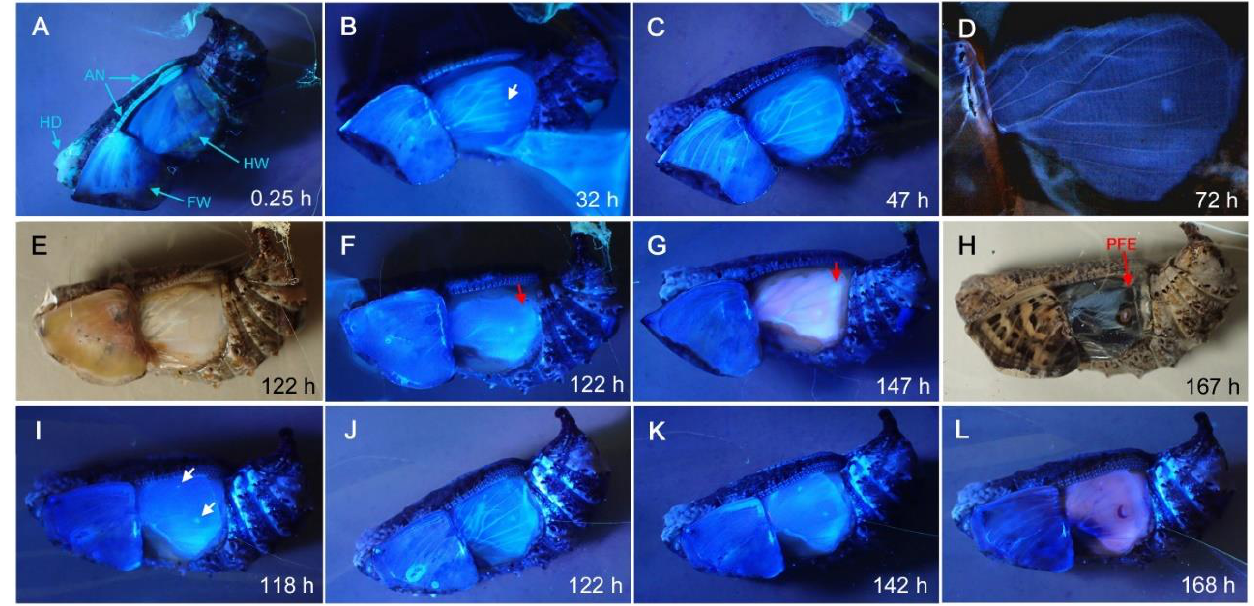
Figure 5. FB28 fluorescent signals under ultraviolet light from forewing-lifted pupae after injection. Post-injection hours are indicated. ( A – D ) A pupa. HD, AN, FW, and HW indicate the head, antennae, forewing and hindwing, respectively. The white arrow in B indicates a pupal cuticle focal spot. ( E – H ) Another pupa. E and H are under white light. The red arrows in F and G indicate fluorescent signals at the peripheral area, which may correspond to PFE in H. ( I – L ) Yet another pupa. Arrows in I indicate pupal cuticle focal spots, which correspond to the foci of eyespots shown in K and L.